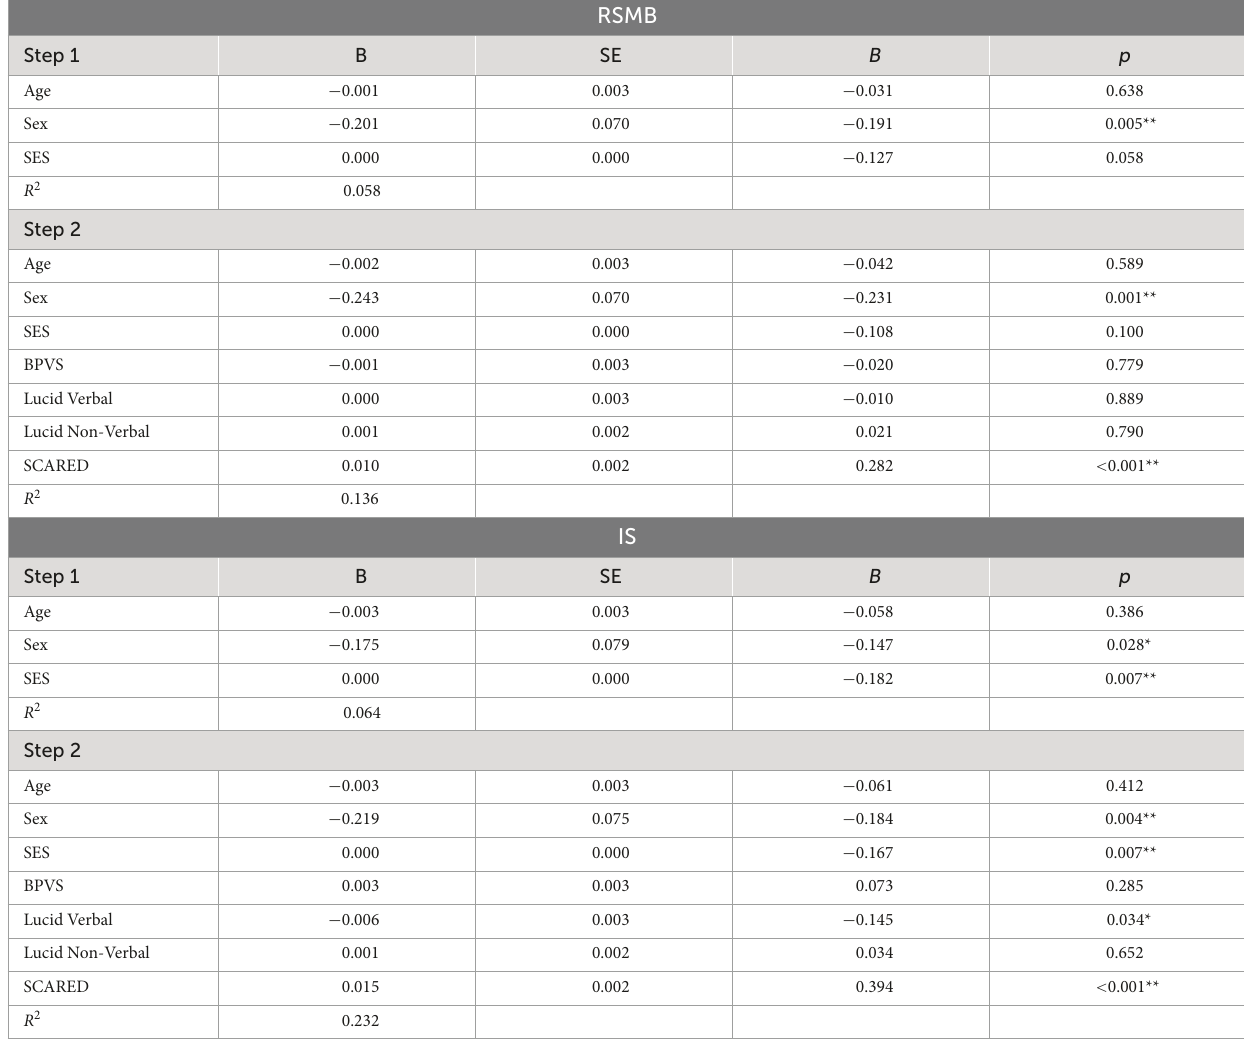
TABLE 5 Regression analysis of RRBs with demographic and developmental variables.